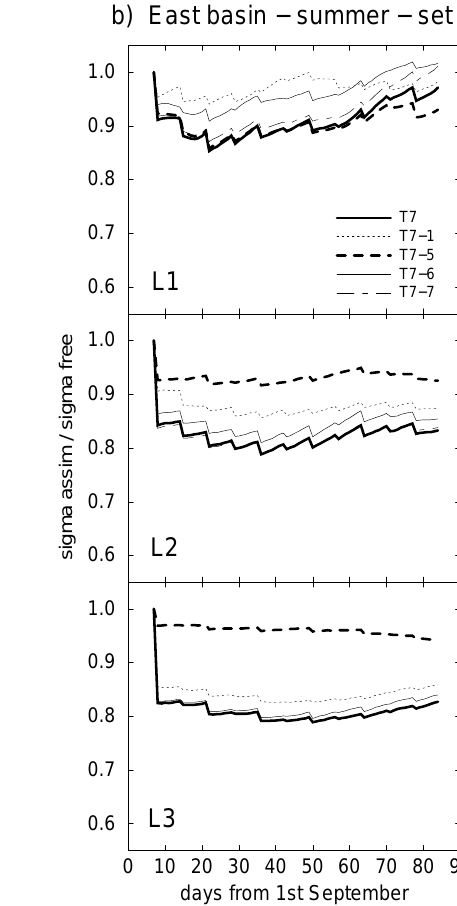
Fig. 6. Time series of temperature relative errors for the eastern basin in the summer OSSEs with sampling strategies of set A (a) and set C (b) . L1 indicates the surface layer, L2 the intermediate layer and L3 the deep layer.